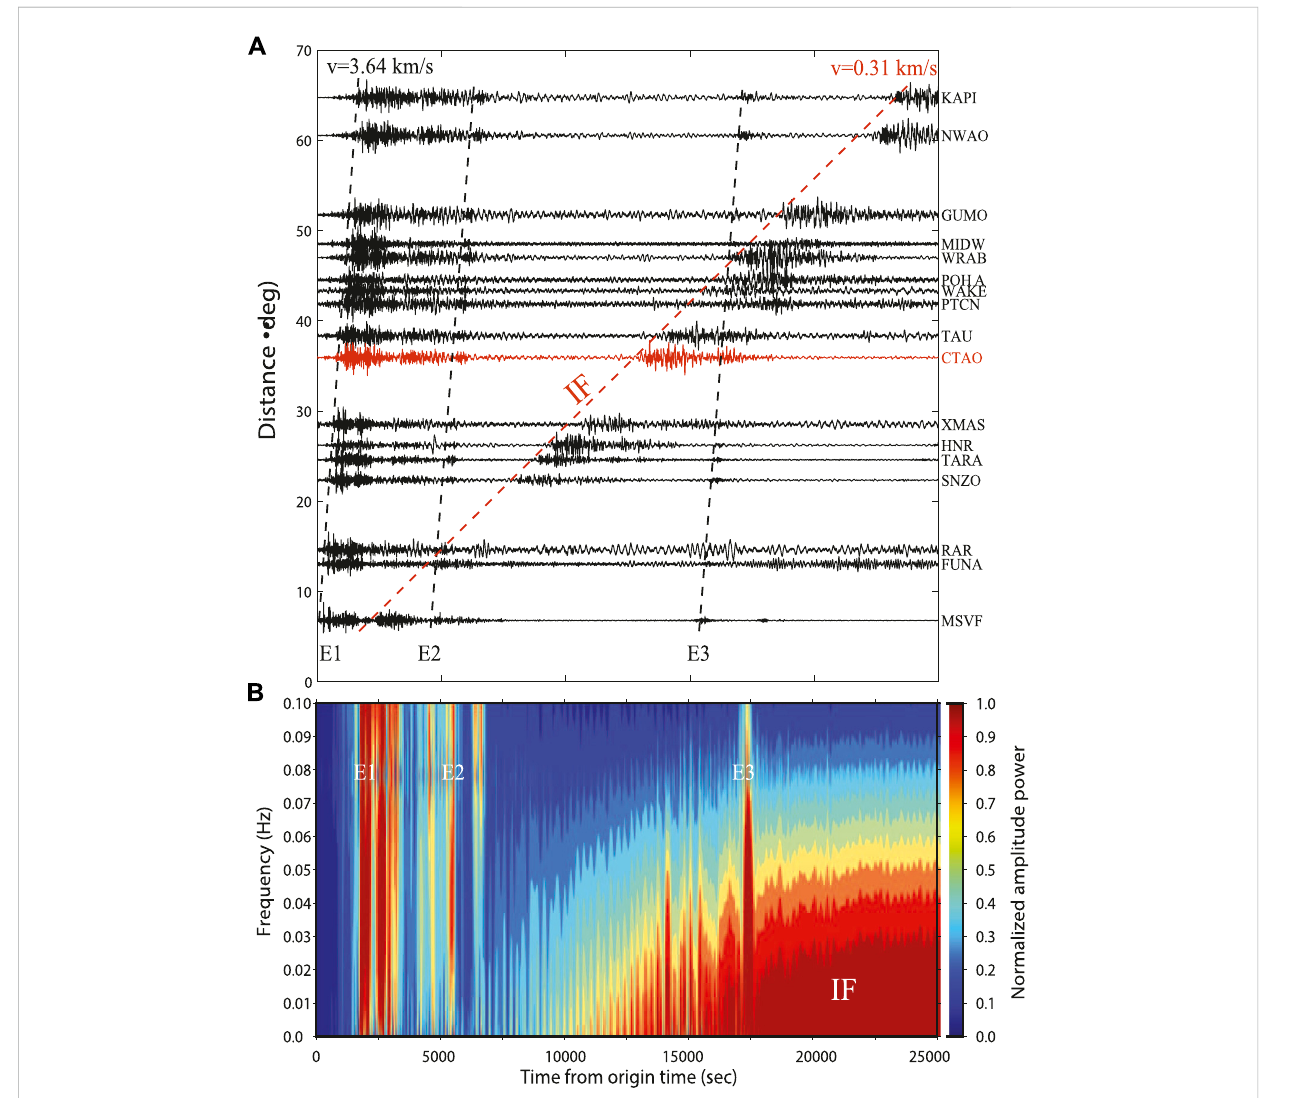
FIGURE 4 (A) Recorded cross section of the vertical-component seismic waveforms. The fi rst pulse of Rayleigh wave is noted as E1. Rayleigh waves from two smallereruptionsarenotedasE2andE3.TheinfrasoundwaveisindicatedbyIF.Weusedthebandpass fi lteringof0.005 – 0.02 Hztobringtheinfrasound wave out of the high-frequency signals. (B) Spectrogram recorded by station CATO at an epicentral distance of 36 ° . E1, E2, E3, and IF are